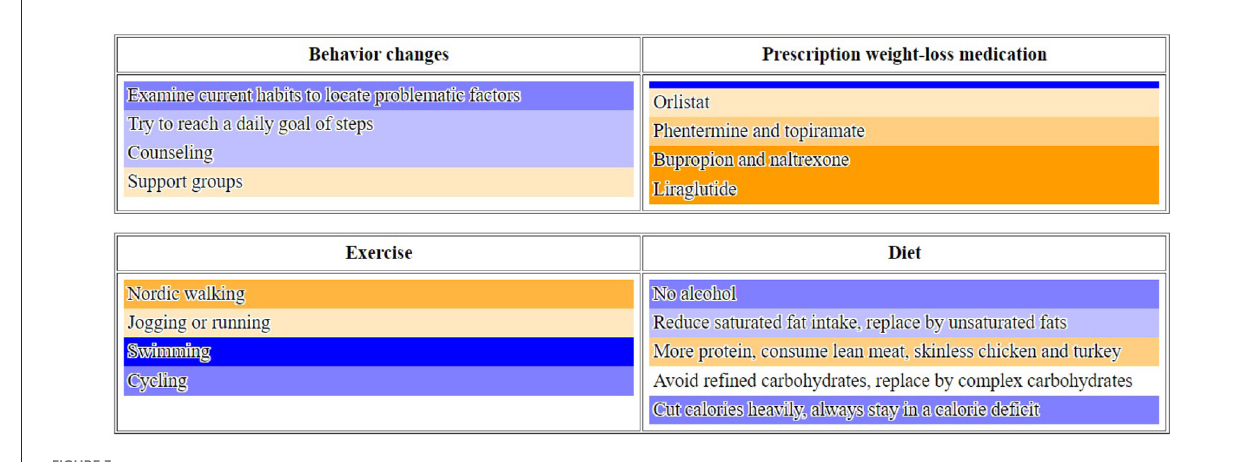
FIGURE3 Example of a set participant’s preference profile and action selection menu for “obesity”